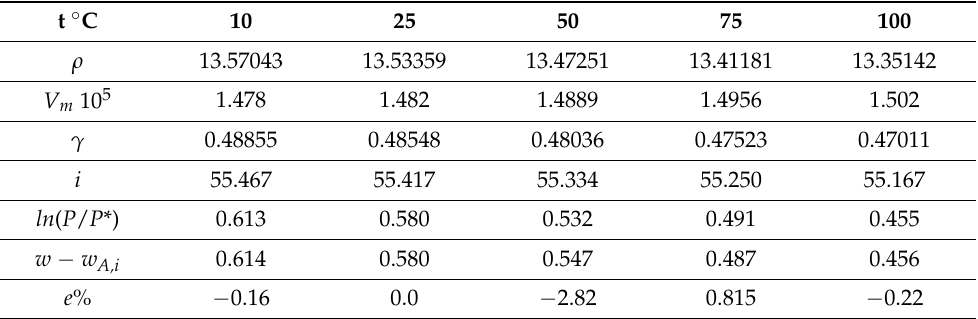
Table 2. The densities ρ (g/cm 3 ), molar volumes V m (m 3 /mol), and surface tensions γ (N/m) at 5 temperatures for Hg, where T m = 234.316 K and M = 200.59 (g/mol) [10].